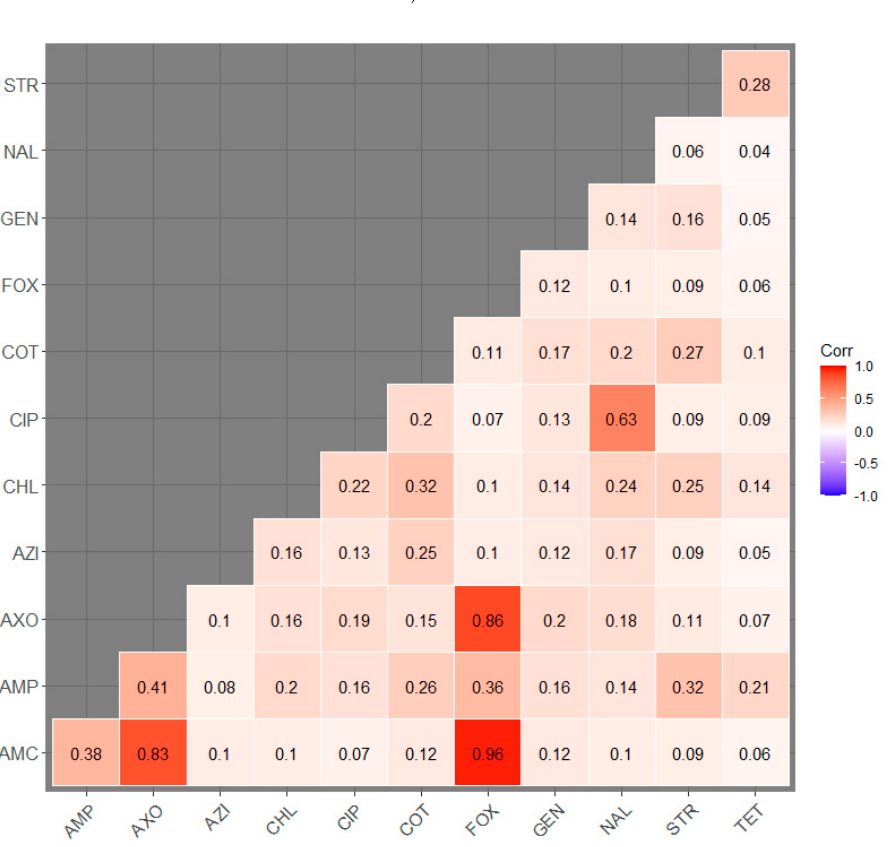
Figure 4. Pearson correlation coefficient heatmap of resistance among twelve antimicrobials in Esch- erichia coli isolates of swine. AMC ‒ Amoxicillin-Clavulanic acid; AMP ‒ Ampicillin; AXO ‒ Ceftriax- one; AZI ‒ Azithromycin; CHL ‒ Chloramphenicol; CIP ‒ Cipro fl oxacin; COT ‒ Trimethoprim-sulfa- methoxazole; FOX ‒ Cefoxitin; GEN ‒ Gentamicin; NAL ‒ Nalidixic Acid; STR ‒ -Streptomycin; TET ‒ Tetracycline.